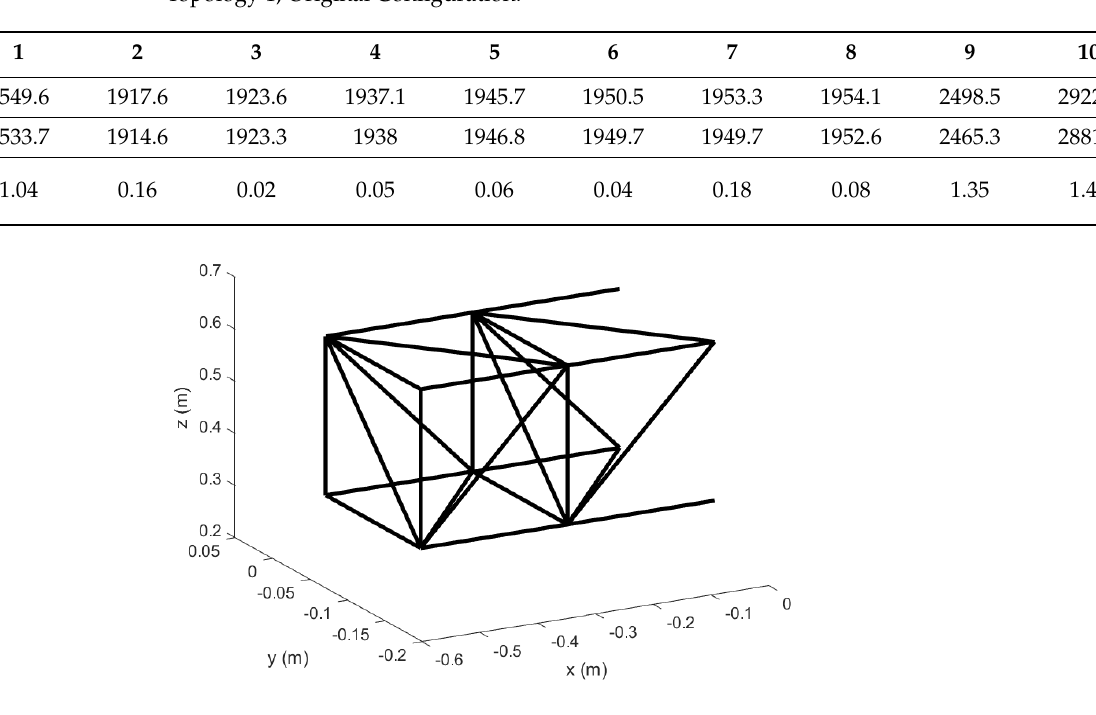
Figure 17. Un–morphed wing in Topology 1 with hinged ends; original configuration.